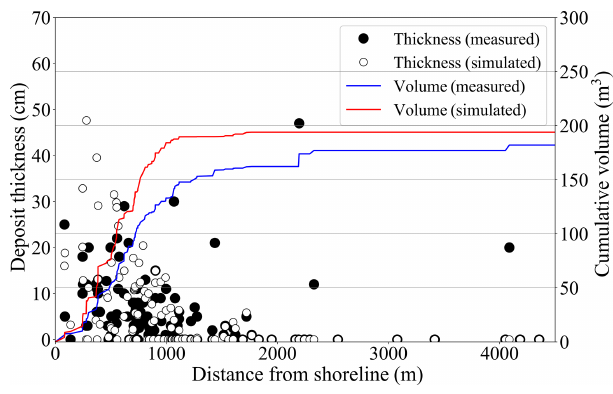
Figure 7. Comparison of field-measured and simulated tsunami de- posit thickness using a representative grain size of d = 0 . 127mm. The black point shows the measured thickness by Jankaew et al. (2008) and Gouramanis et al. (2017), and the white point shows the simulated thickness. The blue and red lines show the cumulative curves of measured data and simulated